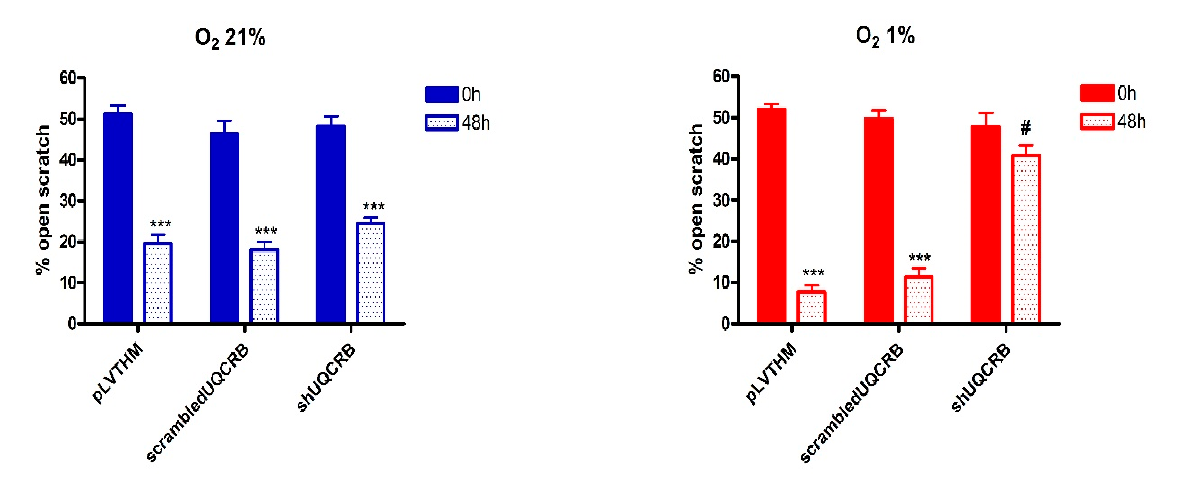
Figure 6. Percentage of open scratch wound in MDA-MB468/pLVTHM, MDA-MB468/scrambledUQCRB and MDA468/shUQCRB cells following 48 h incubation under normoxic (O 2 21%) and hypoxic conditions (O 2 1%) (mean S.E. of 3 independent experiments; two-ways ANOVA results: *** p < 0.001 vs. 0 h same condition; # p < 0.01 vs. MDA-MB468/pLVTHM and MDA-MB468/scrambledUQCRB 48 h).